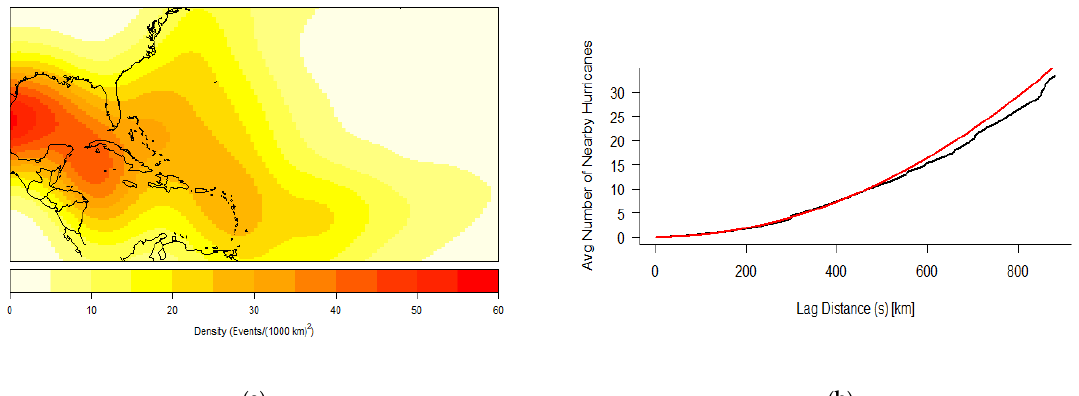
Figure 12. ( a ) Kernel density analysis of RI hurricanes at their initial RI genesis points (1851 – 2017). ( b ) Generalization of K graph for inhomogeneous data of initial RI genesis points with the empirical (black) curve above the theoretical (red) curve for lag distances of 150 km and lower, indicating the likelihood of clustering up to this distance.